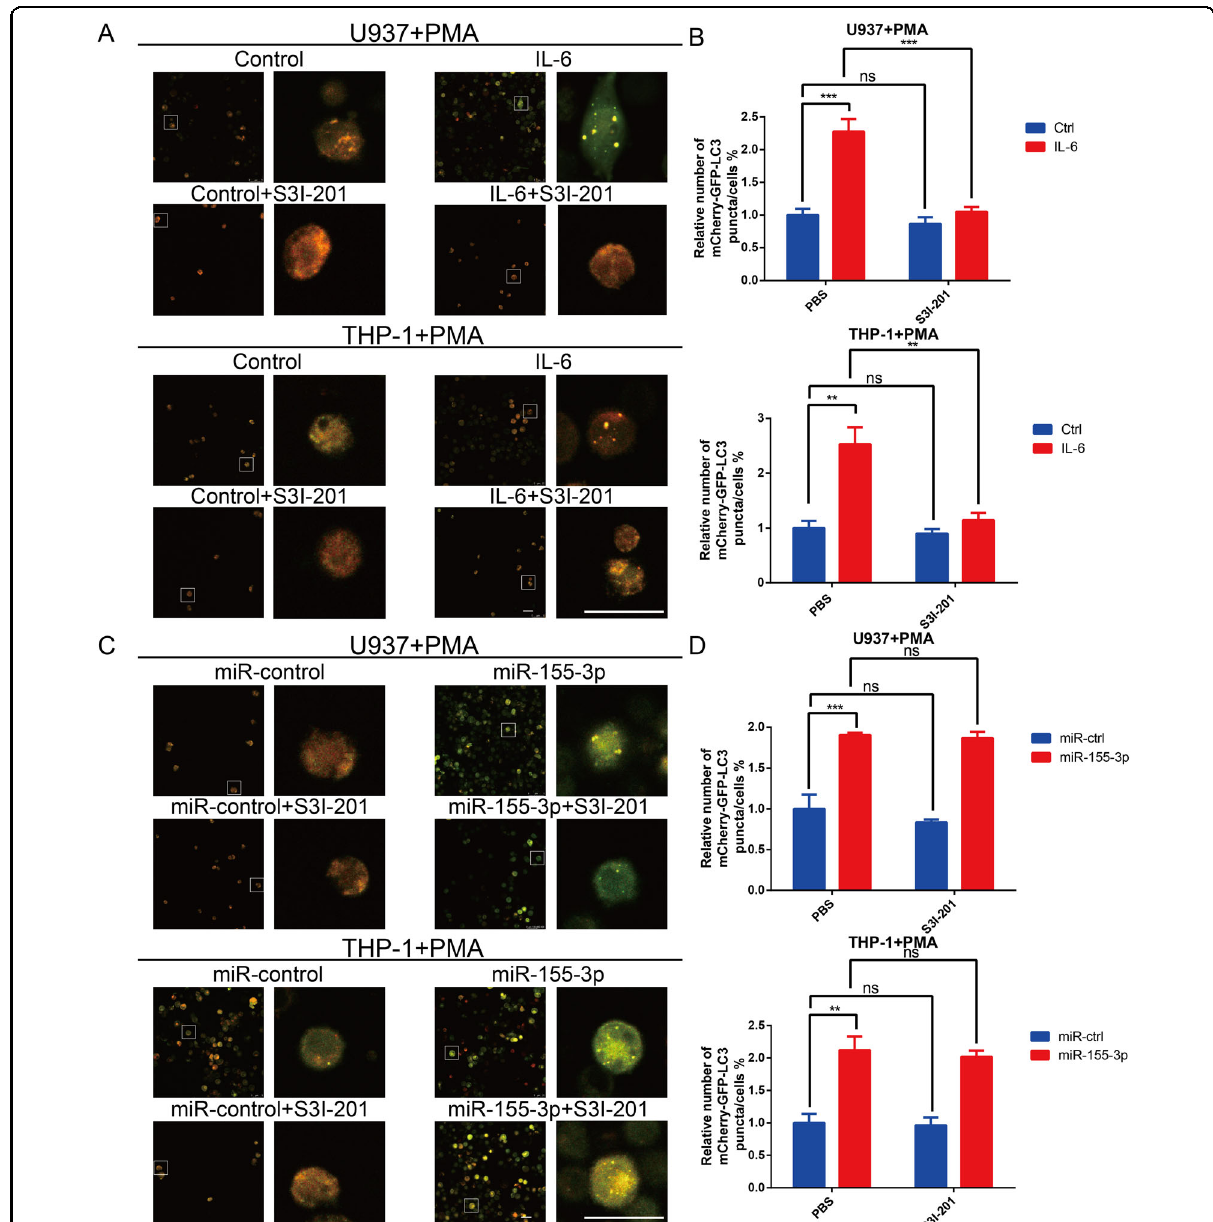
transfected with lentiviruses expressing mCherry ‐ GFP ‐ LC3 plasmid. Then, the mCherry ‐ GFP ‐ LC3-U937 and mCherry ‐ GFP ‐ LC3-THP-1 cells were transfected with control or IL-6 and incubated with PMA (100 ng/ml) for 24 h in vitro to induce them to differentiate into macrophages. S3I-201 was used to inhibit STAT3 activation. Macrophages of different groups were visualized by confocal microscopy. Representative images are shown (Scale bar, 25 μ m). B The number of mCherry ‐ GFP-LC3 puncta in each cell was quanti fi ed. C The mCherry ‐ GFP ‐ LC3-U937 and mCherry ‐ GFP ‐ LC3-THP-1 cells were transfected with miR-control or miR-155-3p and incubated with PMA (100 ng/ml) for 24 h in vitro to induce them to differentiate into macrophages. S3I-201 was used to inhibit STAT3 activation. Macrophages of different groups were visualized by confocal microscopy. Representative images are shown (Scale bar, 25 μ m). D The number of mCherry ‐ GFP-LC3 puncta in each cell was quanti fi ed. (* P < 0.05; ** P < 0.01; *** P < 0.001; n =